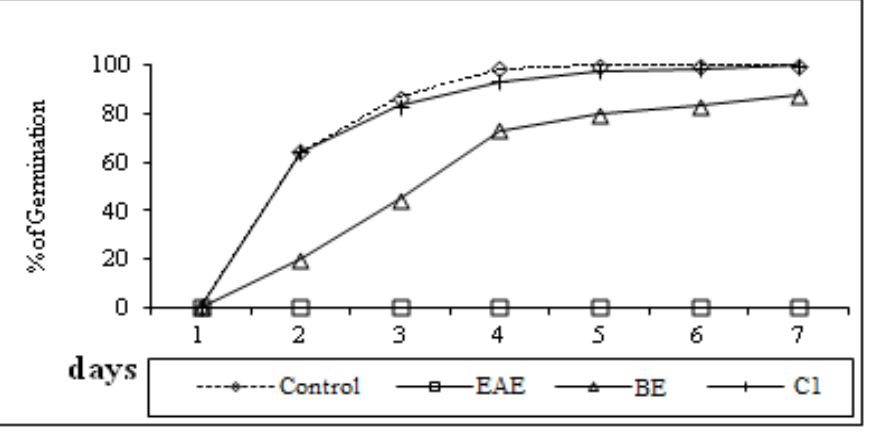
Figure 4. Germination of lettuce seeds in the presence (1 mg/mL) of distilled water (control), ethyl acetate (EAE), n-butanolic extract (BE) and two diastereoisomers ( 1a and 1b ) (C1) of F. lutea